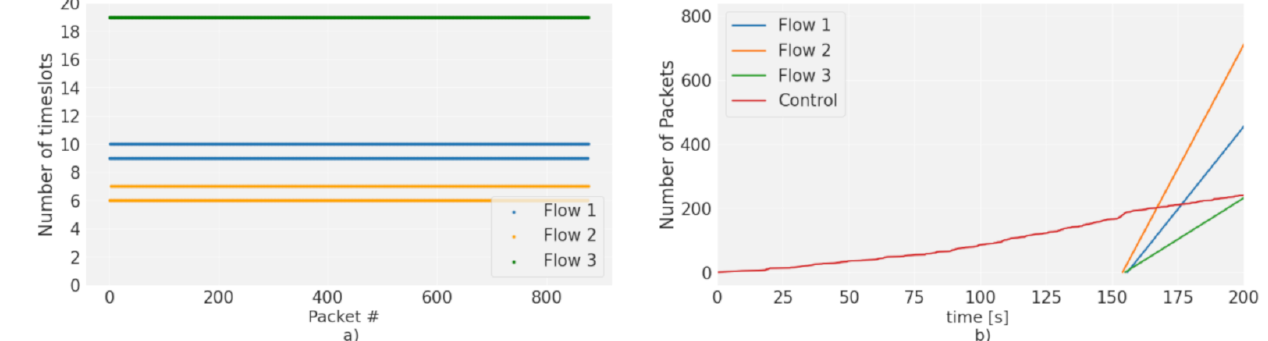
Figure 11. ( a ) Packet inter-arrival time for all flows, ( b ) Number of packets by flow.